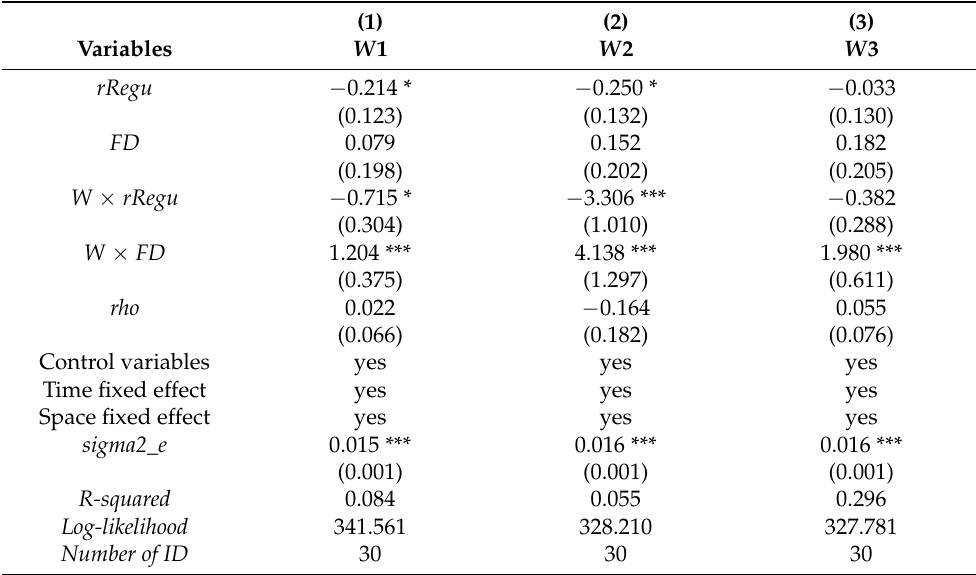
Table 11. Robustness test results under each spatial weight matrix of replacement environmental regulation